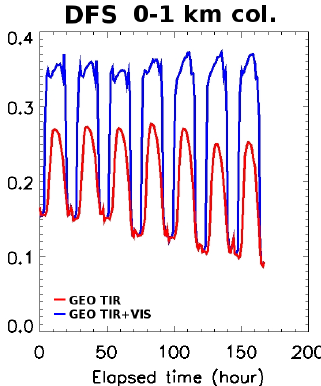
Figure 9. 0–1km DFS, for all the pixels of the red square domain (see Fig. 2), over time (period between the 9 to 15 July 2009) for GEO TIR (in red) and GEO TIR + VIS (in